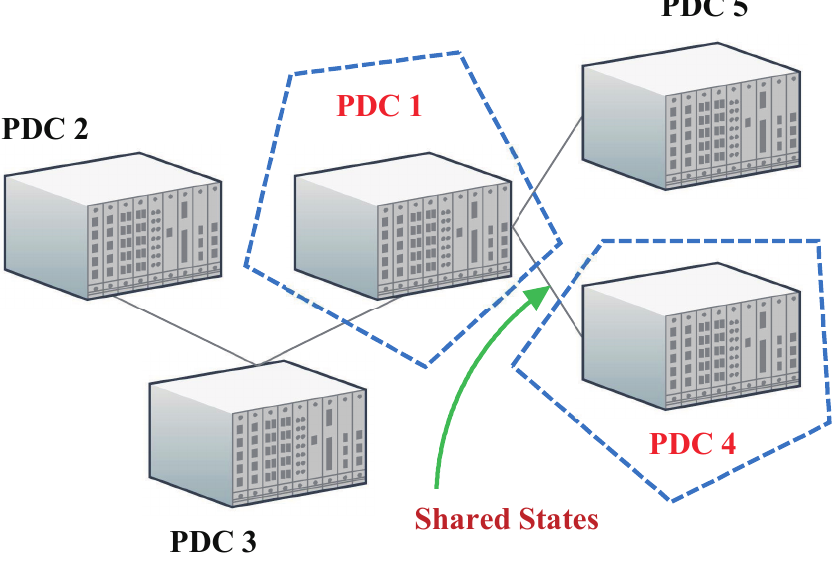
Figure 2. An example of a phasor data concentrator (PDC)